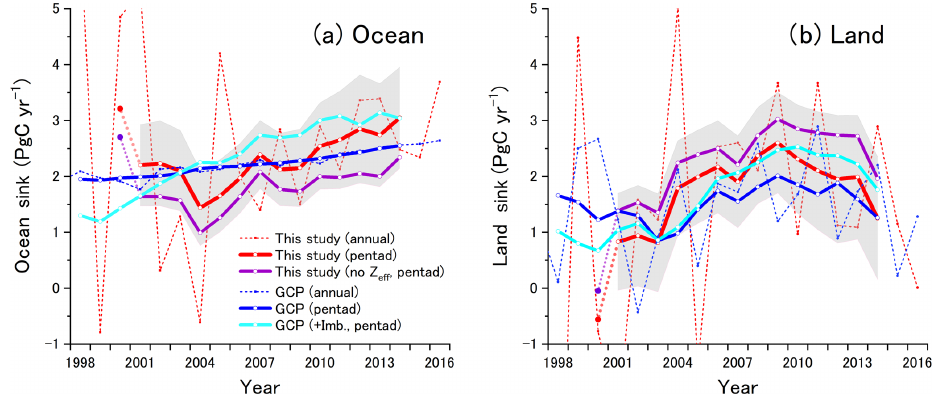
Figure 8. Temporal variations in (a) ocean and (b) land biospheric sinks estimated from APO variations of this study (red) and process-based models of GCP (blue). The thin dashed lines represent the annual sinks, and the thick lines represent the pentad sinks. The purple lines represent the pentad sinks based on APO without ocean outgassing correction ( Z eff ), and the light blue lines represent the sinks of GCP with the imbalance sinks added. The uncertainty associated with the pentad sinks with Z eff corrections is shown as shaded area.